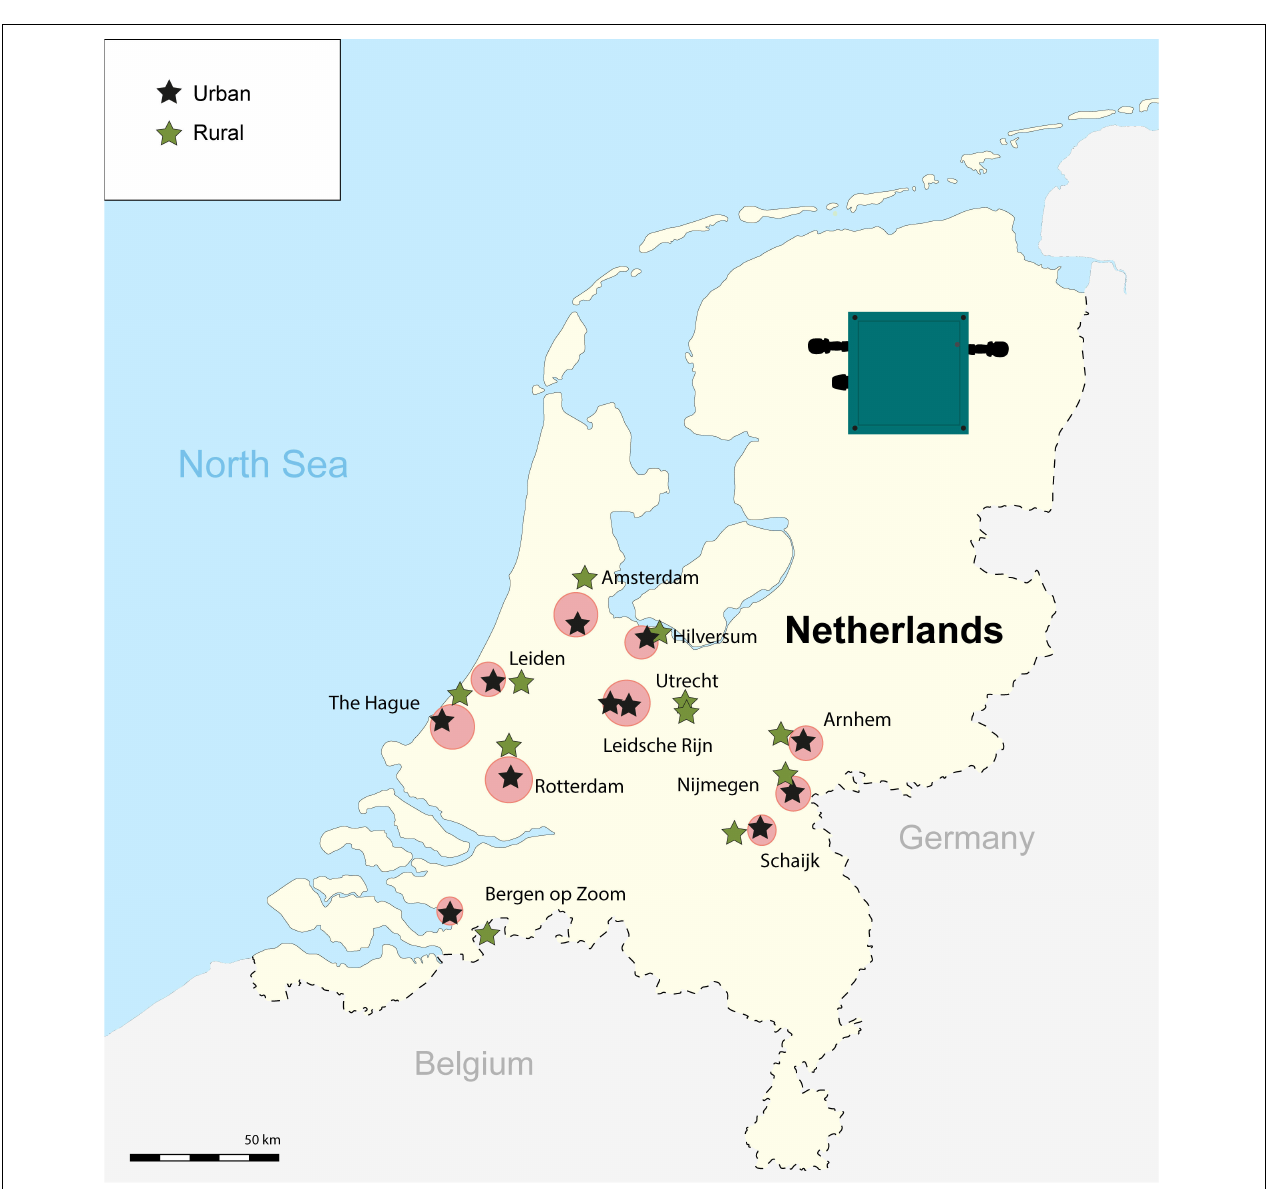
FIGURE 1 | Map with the locations of the 11 urban and rural pairs inside and outside main cities across the Netherlands. The black symbols represent the urban sites and the green symbols represent the rural sites. The red circles indicate the cities, with size reflecting relative size. We also show the image of the automatic recorders (Song Meter SM1) used to conduct our 24-h